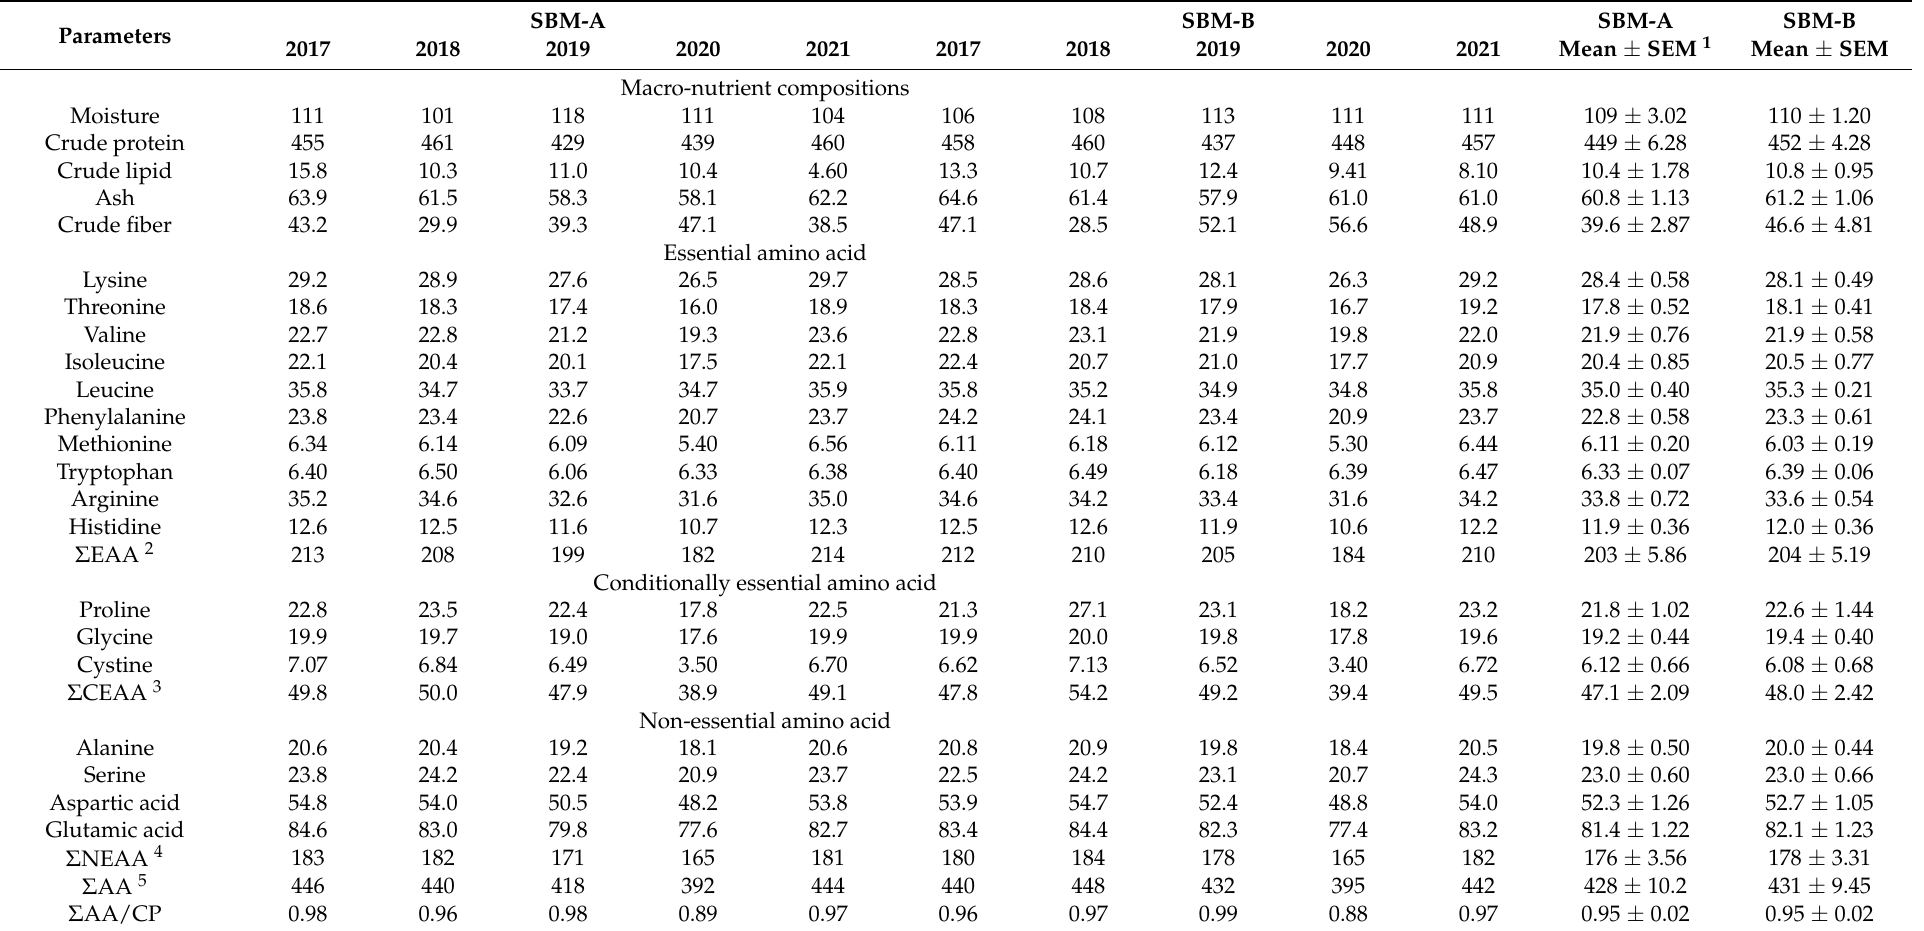
Table 3. Macro-nutrient and amino acid compositions of tested soybean meals (SBMs) processed on the same production line with beans from different origins (g/kg).